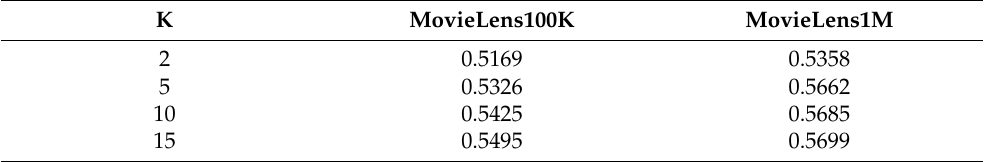
Table 10. The impact of list length on NDCG@10.